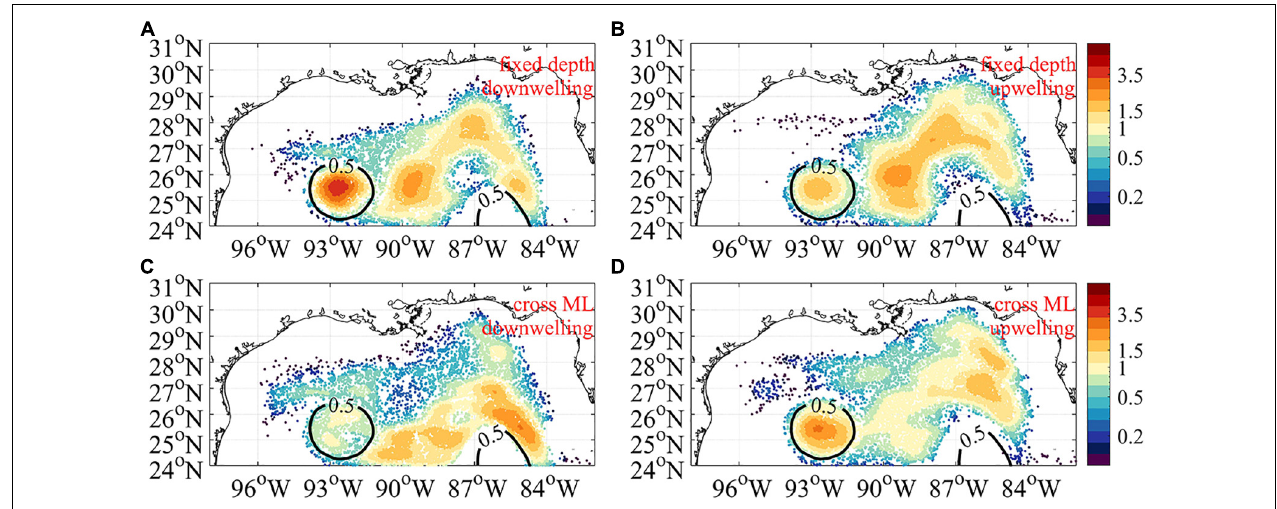
FIGURE 9 | KDE of particles selected based on their vertical absolute displacement after 10 days (A,B) and cross-mixed layer behavior (C,D) calculated considering all four winter SP releases (see text for details). The particles are initially released at 5 m [panels (A,C) labeled as “downwelling”] and at deeper depths [ (B) release type 1 ; (D) release type 2 , labeled as “upwelling”]. Black contours indicate the 0.5 m sea surface height isobaths and outline the location of the LC and the